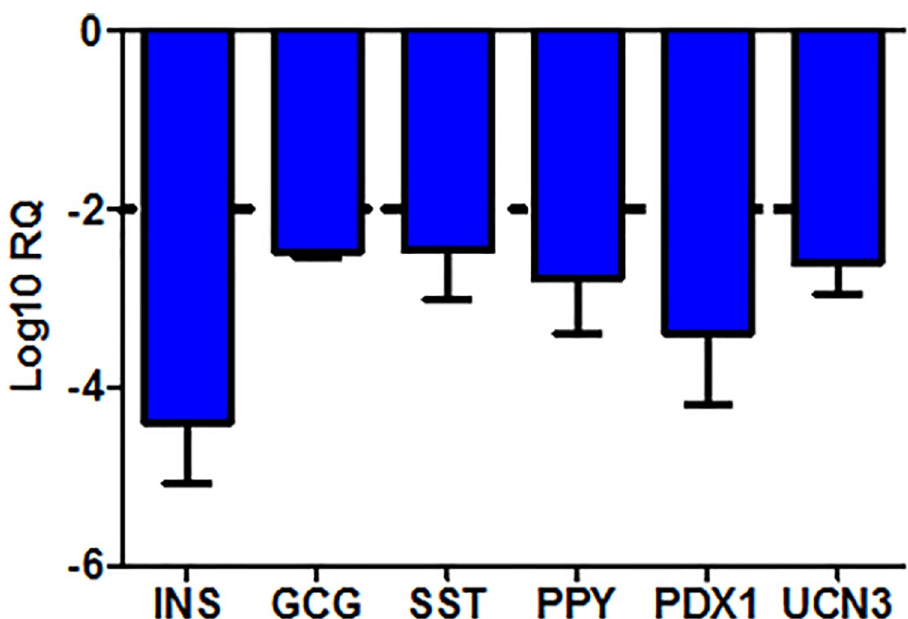
Fig 2. NI gene expression profiles. Shown are gene expression profiles of freshly prepared human Neo-Islets (hNIs) prior to i.p. administration to diabetic NOD/SCID mice, normalized to expression levels of whole, uncultured human islets. Log10 (RQ) values were calculated for NIs and graphed as the mean ± SEM. Log10(RQ) � ± 2 (hashed line) was considered statistically significant. Islet associated genes (INS, GCG, SST, PPY, PDX1, and UCN3) are expressed in human NIs prior to administration, but at significantly reduced levels compared to those of freshly isolated human